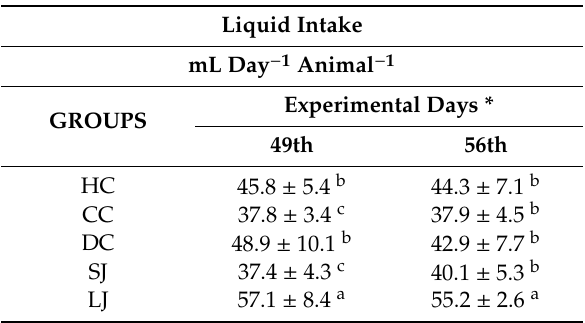
Table 1. Liquid intake before and after colitis